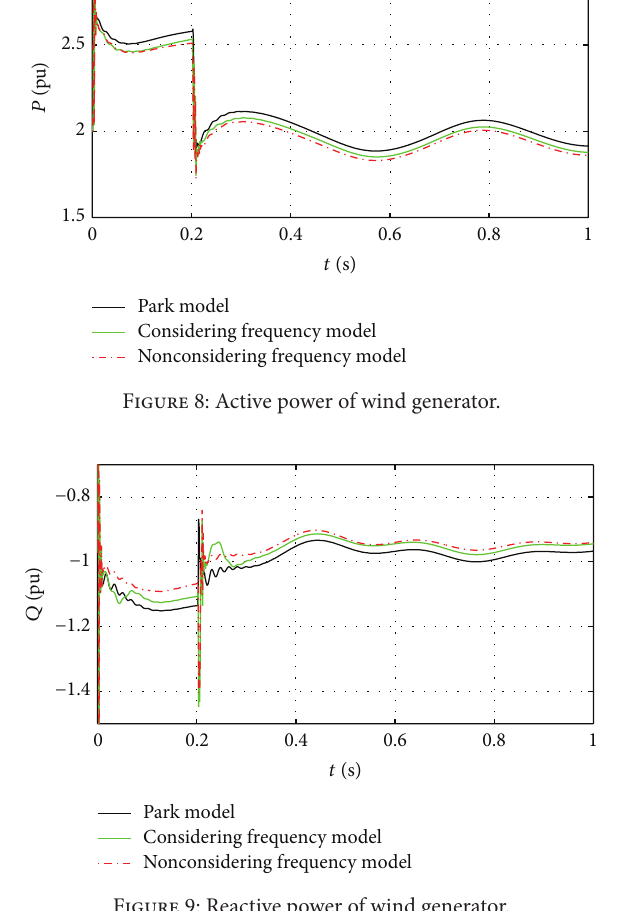
Figure 9: Reactive power of wind generator.